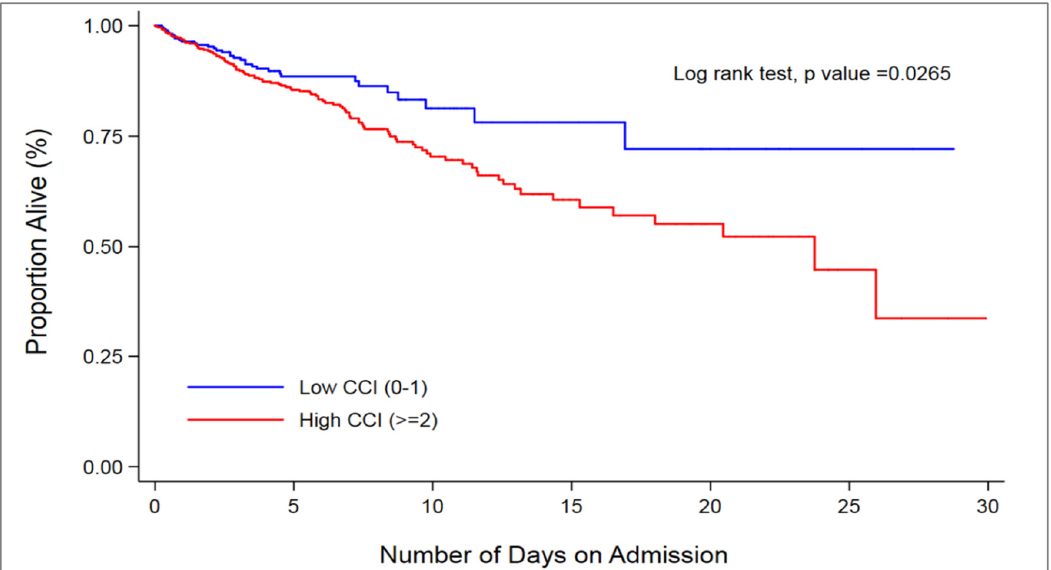
Figure 2. Unadjusted Kaplan–Meier survival curves for patients admitted for acute stroke stratified by Charlson Comorbidity Index (CCI) categories.